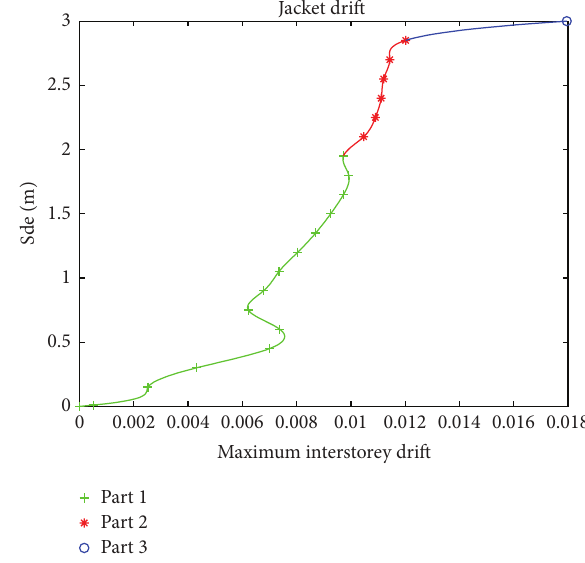
Figure 10: The IDA curve of storey level